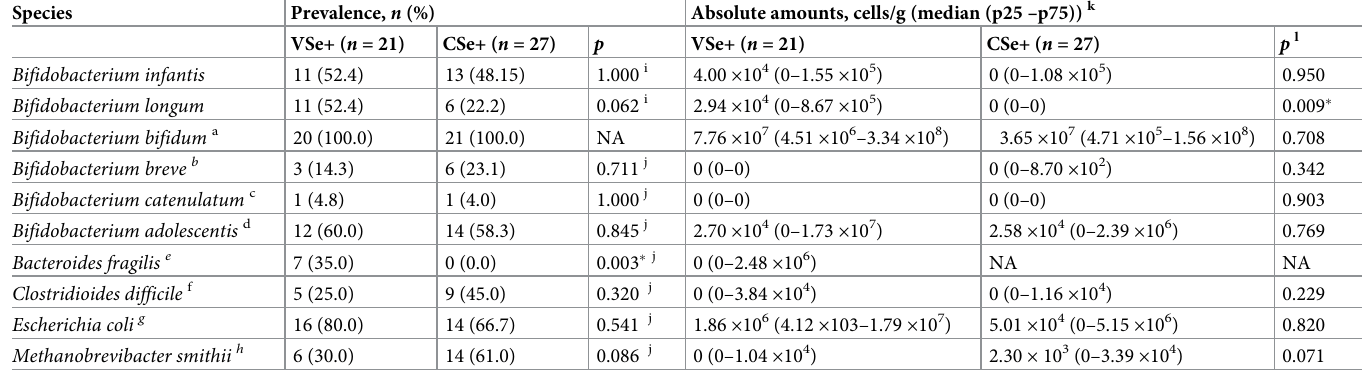
Table 4. Prevalence and absolute amounts of selected species obtained by qPCR from the feces of vaginally and cesarean born, exclusively breastfed infants from secretor mothers.